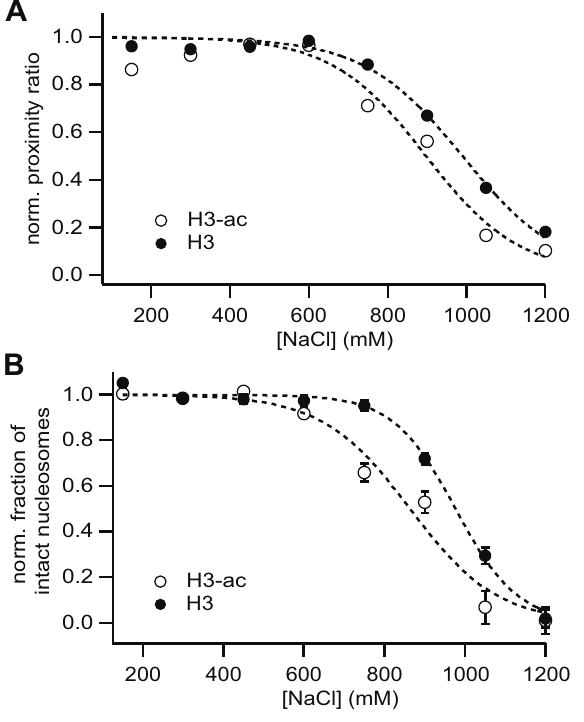
Figure 6. smFRET results on nucleosome stability are consis- tent to m psFRET data. ( A ) Average proximity ratio calculated from all photons from double-labeled nucleosomes as a function of salt concentration. Photons from the donor and transfer channel were